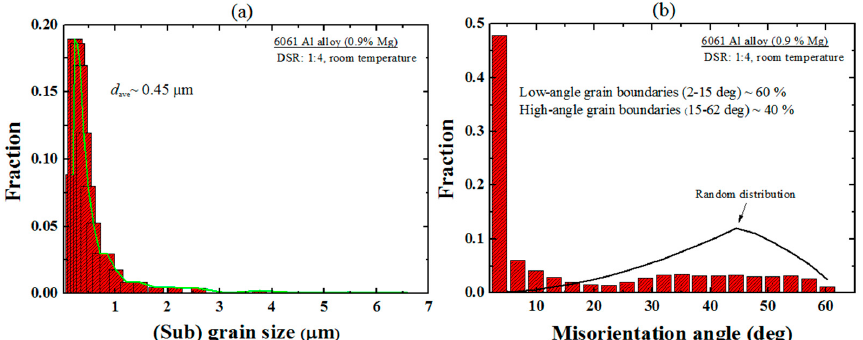
Figure 4. ( a ) Grain size distribution and ( b ) grain boundaries misorientations of the DSR-deformed 6061 Al alloy. The green line in Figure 4a shows additionally the grain size distribution.